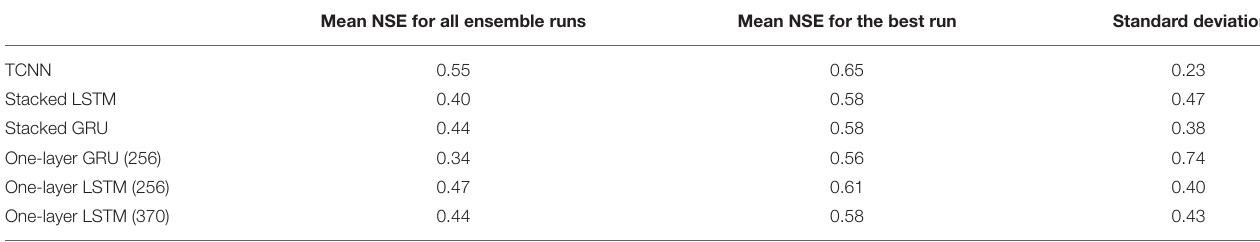
TABLE 1 | Mean and standard deviation for ensemble prediction comparison with different